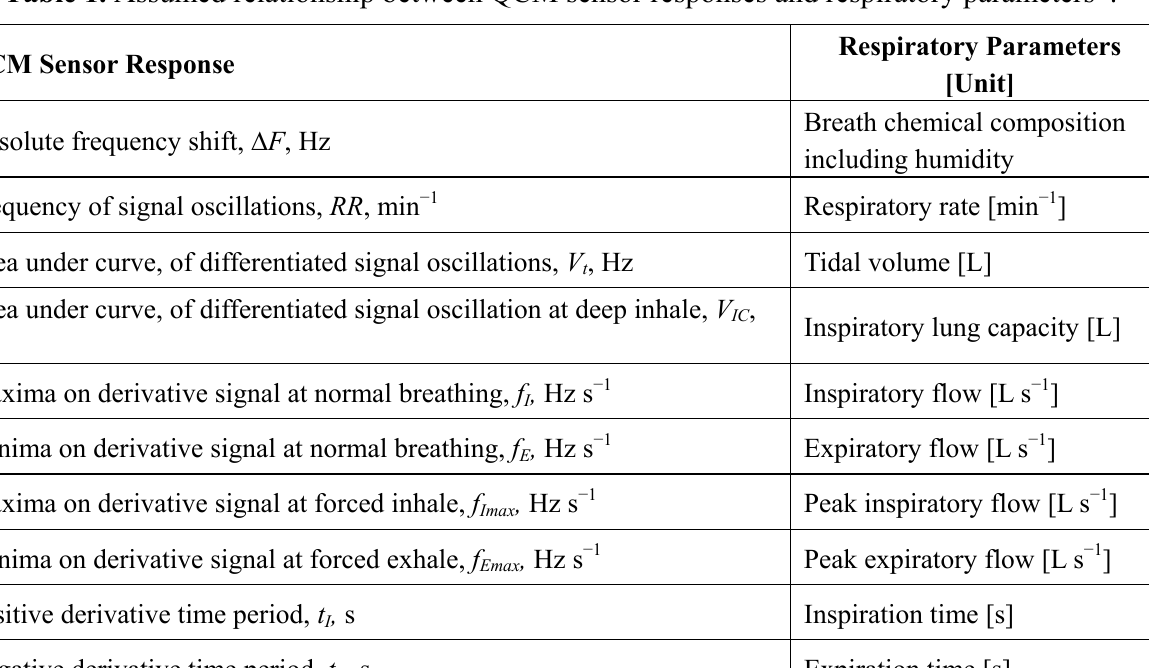
film to human 15